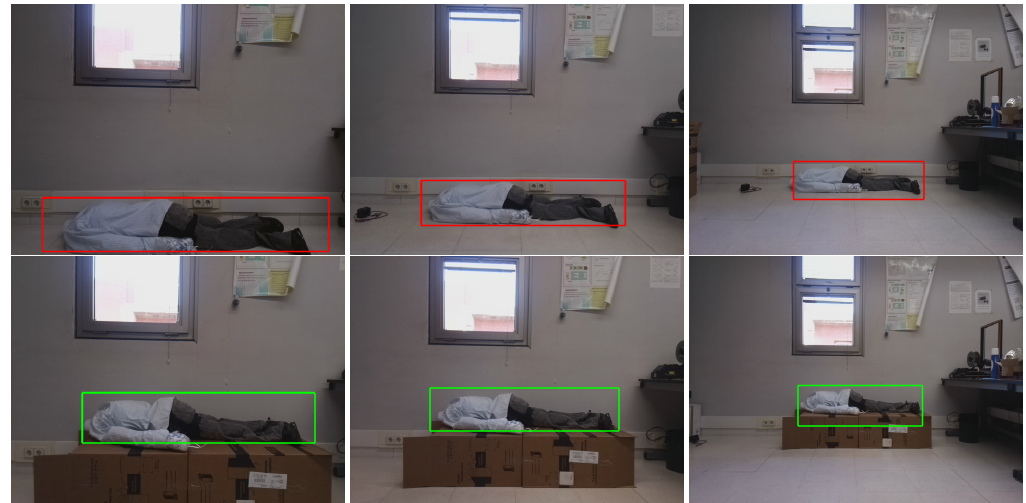
Figure 7. Fall/nonfall detection 1.5, 2 and 3 m away (each pair of images are in the same column).